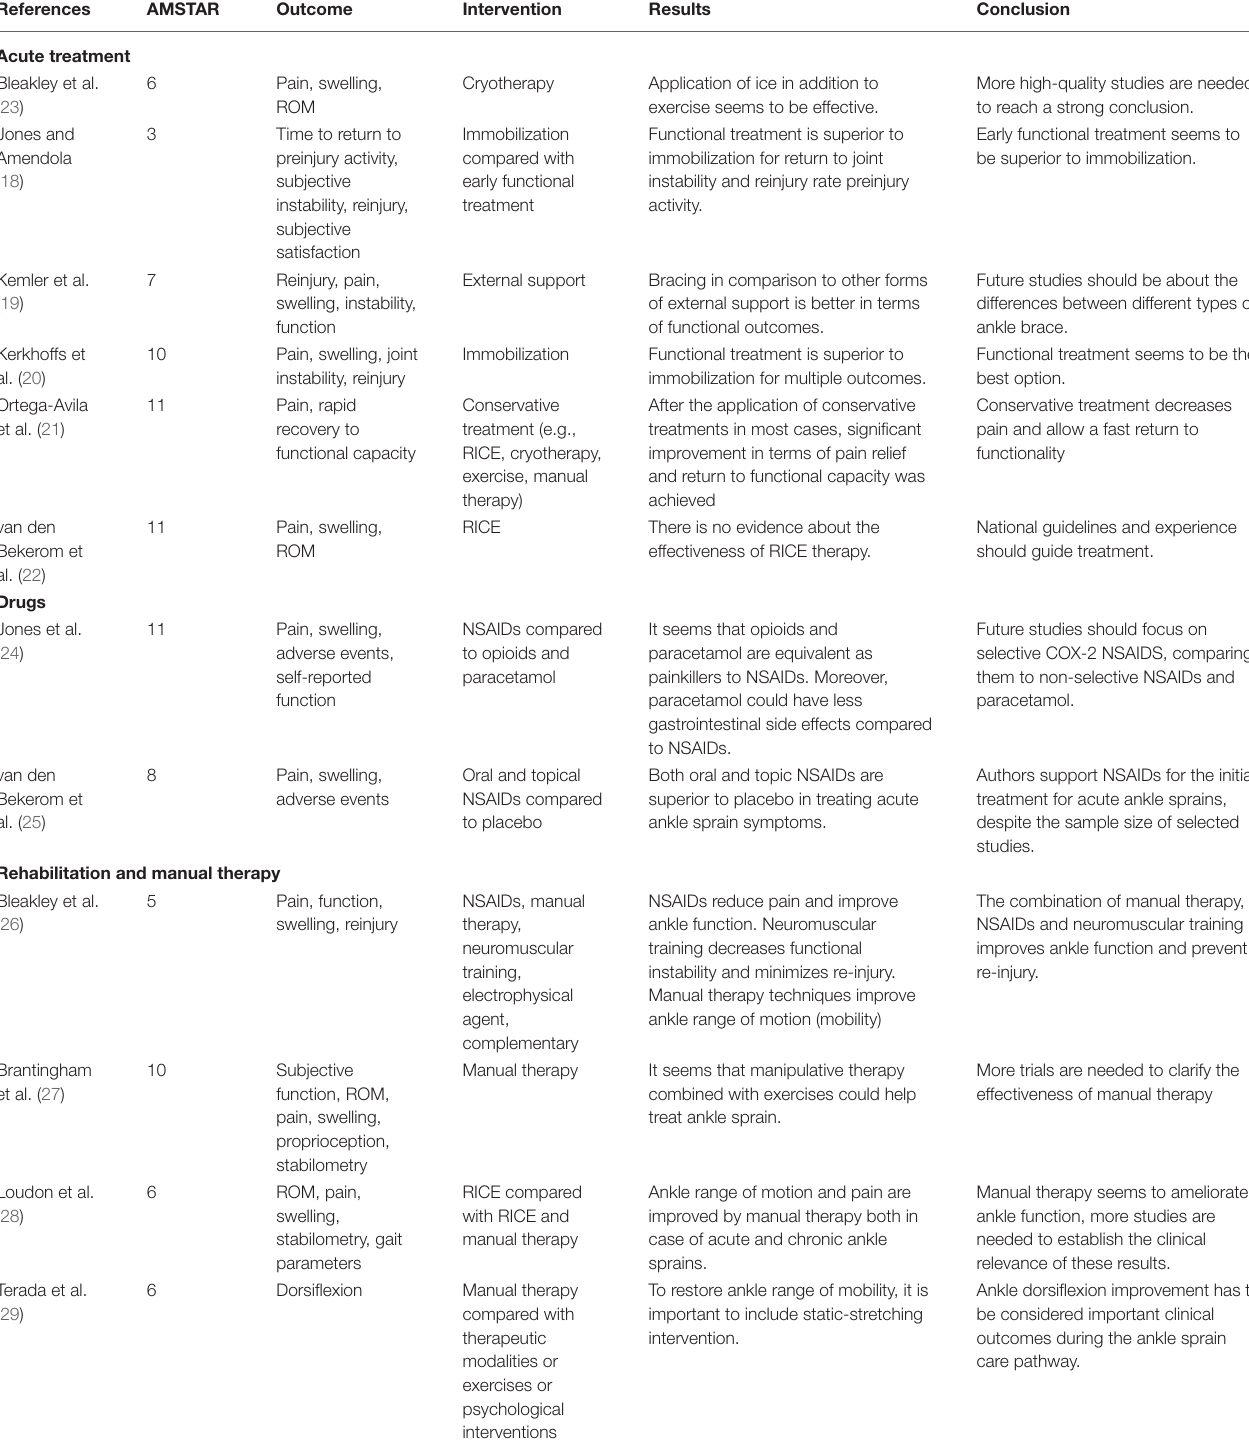
TABLE 3 | Results of the best evidence synthesis from the